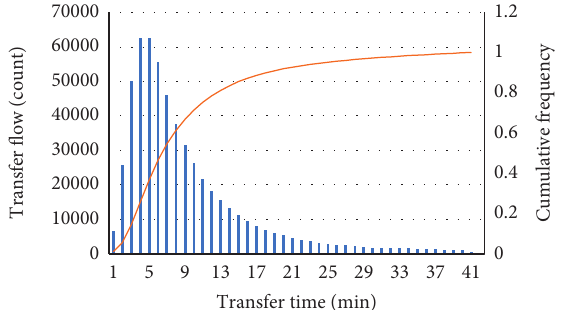
Figure 2: Cumulative frequency distribution of transfer flow on different transfer